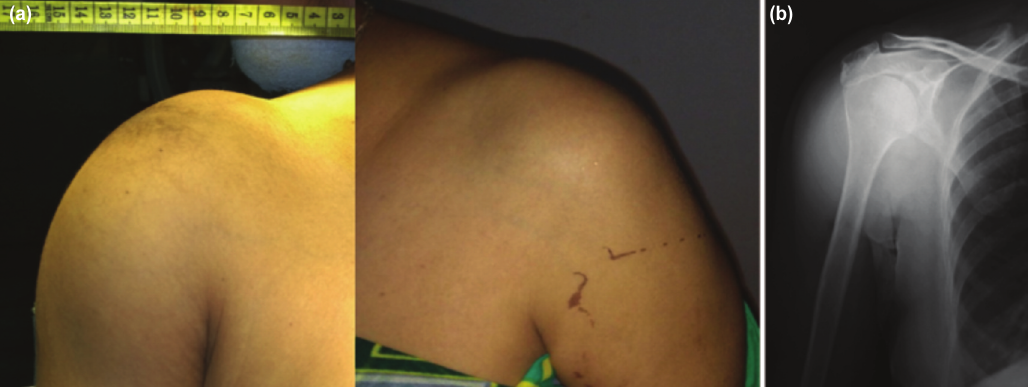
(a) Clinical photographs of sub-deltoid swelling. (b) Plain radiograph of right shoulder with normal glenohumeral articulation Fig. 1: and sub-deltoid soft tissue shadow.